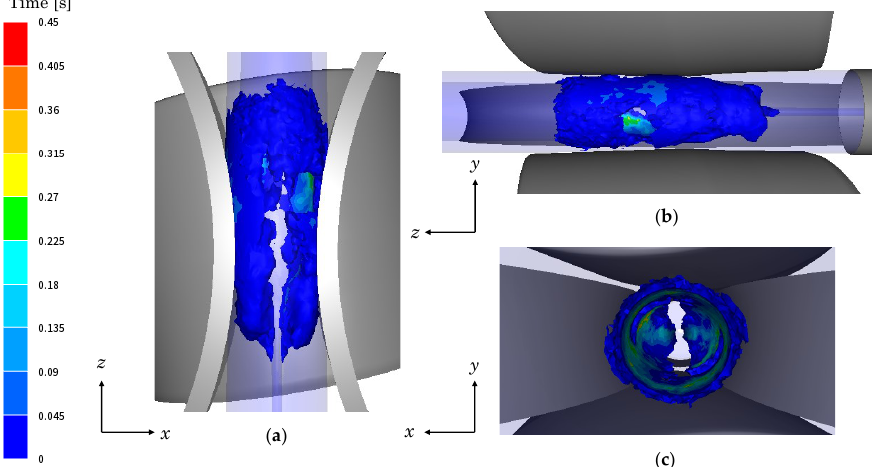
Figure 6. Time during which the material exhibits dynamic recrystallization (DRX) in the RTP process: ( a ) upper view, ( b ) lateral view and ( c ) front